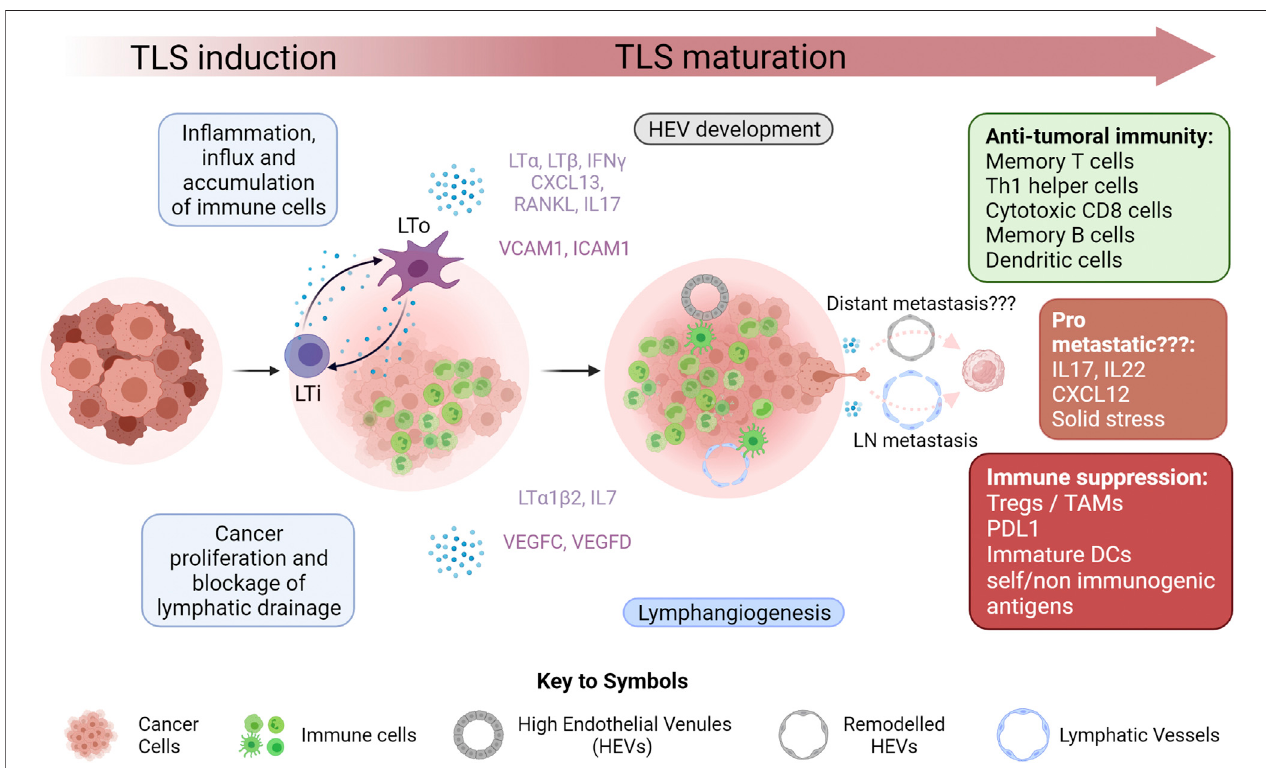
FIGURE 1 | Tertiary Lymphoid Structure Development in Cancer In fl ammation within the microenvironment of growing tumors results in increased in fi ltration of immune cells. This, coupled with the effect of rapidly proliferating cancer cells, often results in blockage of draining lymphatic vasculature, leading to an accumulation of immunecellsandinitiationoftertiarylymphoidstructure(TLS)formationwithinthetumororatitsboundary.Akeystepinthisinitiationistheinteractionoflymphoidtissue inducers (LTi) with lymphoid tissue organizers (LTo). The nature of these cells is highly variable in cancer. This interaction results in the secretion of a myriad of cytokines favoring the maturation of the TLS by recruiting various immune cells through newly created lymphatic vessels and high endothelial venules (HEVs). While this maturation often results in a strong anti-tumoral immune response, it has also been shown to occasionally favor immunological tolerance mainly by negatively affecting antigen presentation machinery and by recruiting immune suppressive cells such as regulatory T cells (Tregs) and tumor associated macrophages (TAMs). This new vasculature has a potential role in tumor metastasis by acting as conduits for metastasizing cancer cells. Lymphangiogenesis has been correlated with increase lymph node (LN) metastasis. Whether or not HEVs are linked to distant metastasis still remains to be de fi nitively proven. The cytokine rich environment of the TLS while being favorabletoanti-tumorimmunityhasalsobeenshowntohavepro-metastaticpotentialincertaincases.EventuallyTLSsincancercanorganizeintomorede fi nedLNlike structures with T cell zones and B cell follicles but this was not depicted in this fi gure.